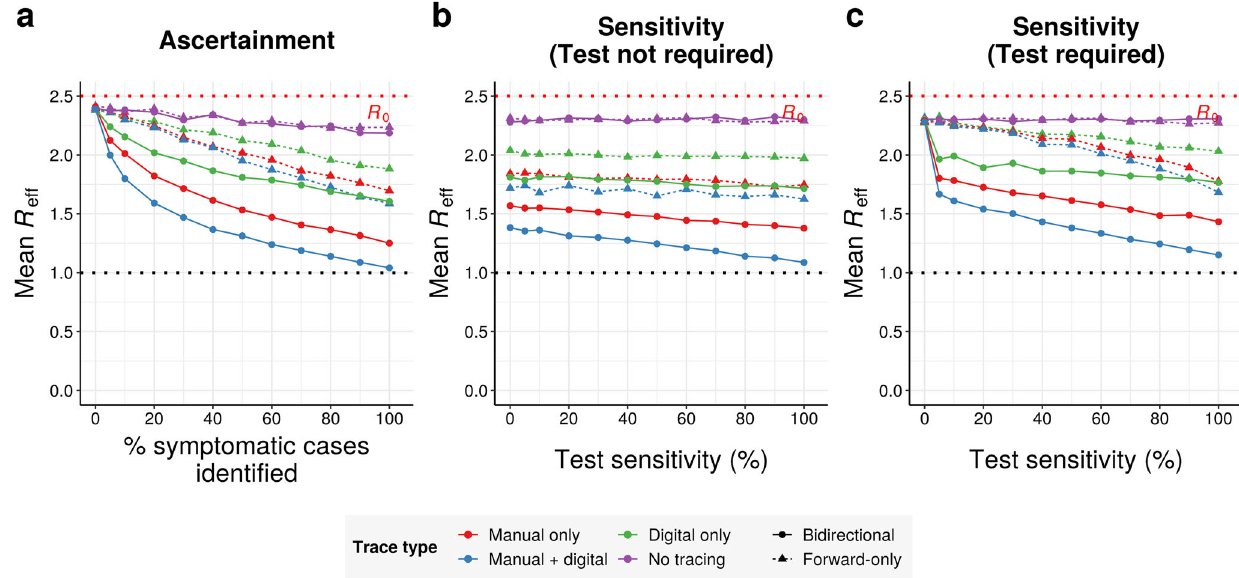
Fig. 3 Bidirectional tracing under reduced ascertainment and test sensitivity. a Mean R eff achieved by different tracing strategies as a function of the percentage of symptomatic cases that can be identi fi ed by health authorities on the basis of symptoms alone, assuming 70% test sensitivity. b Mean R eff achieved by different tracing strategies as a function of test sensitivity, assuming 50% ascertainment of symptomatic cases. c As in ( b ), but allowing contact tracing to be initiated from symptomatic cases on the basis of symptoms alone (i.e., without a positive test result). All panels assume 90% probability of trace success, a 6-day manual tracing window, high (80%) smartphone coverage, and median disease parameters (Table 1). Isolation on the basis of symptoms can dampen the outbreak even in the absence of